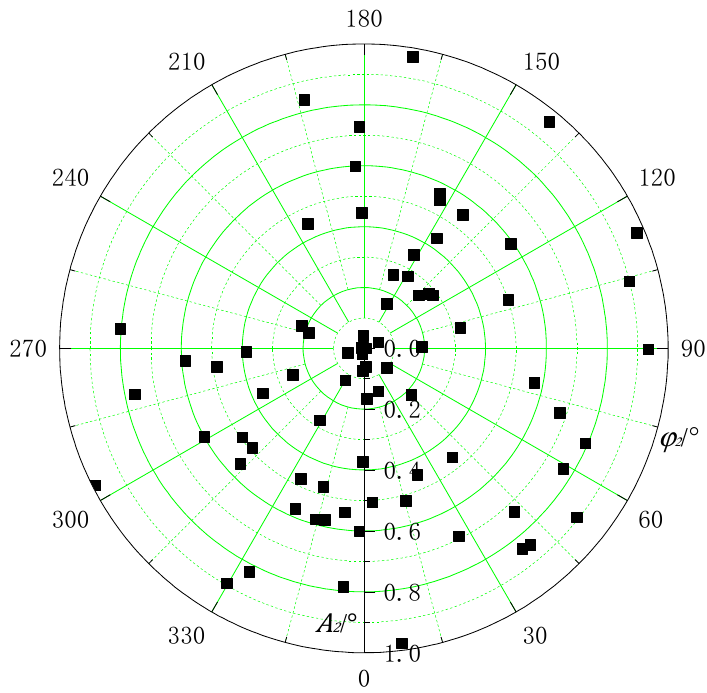
Figure 10. The initial population.